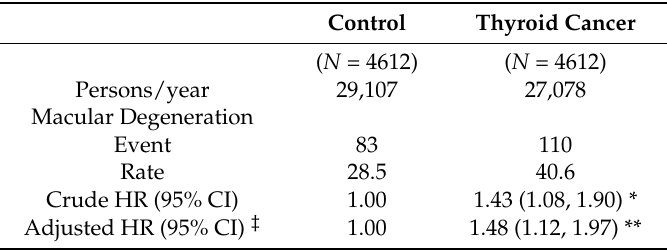
Table 5. Incidence and hazard ratio of macular degeneration in patients with thyroid cancer compared to subjects without thyroid cancer by propensity score-based sensitivity